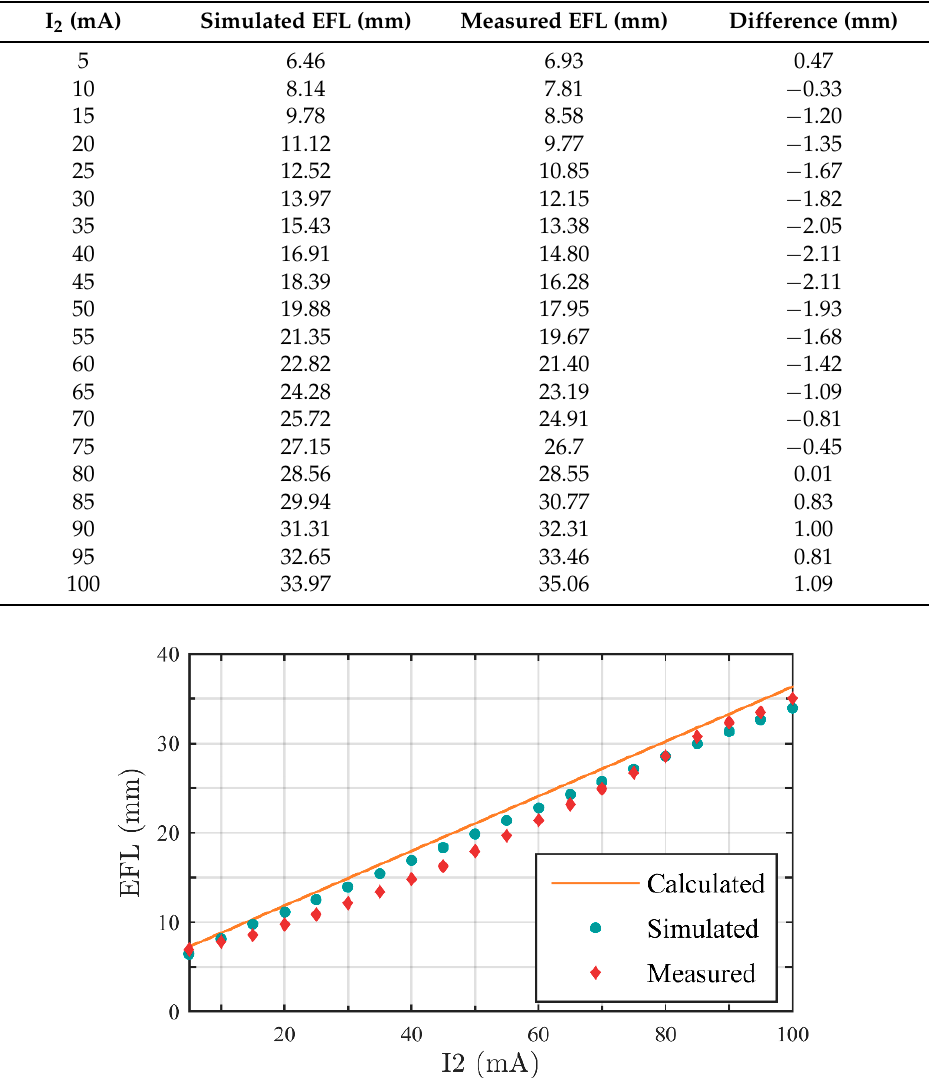
Table 5. Comparisons between simulated EFL and measured EFL.